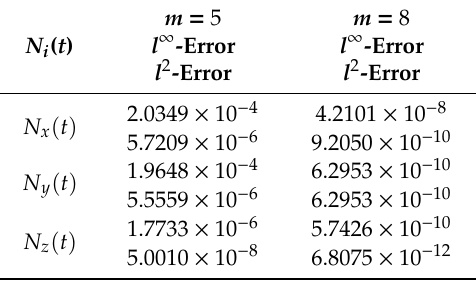
Table 1. Comparison of ( l ∞ ) and ( l 2 ) errors at a = b = 0.8, m = 5, 8 for integer order